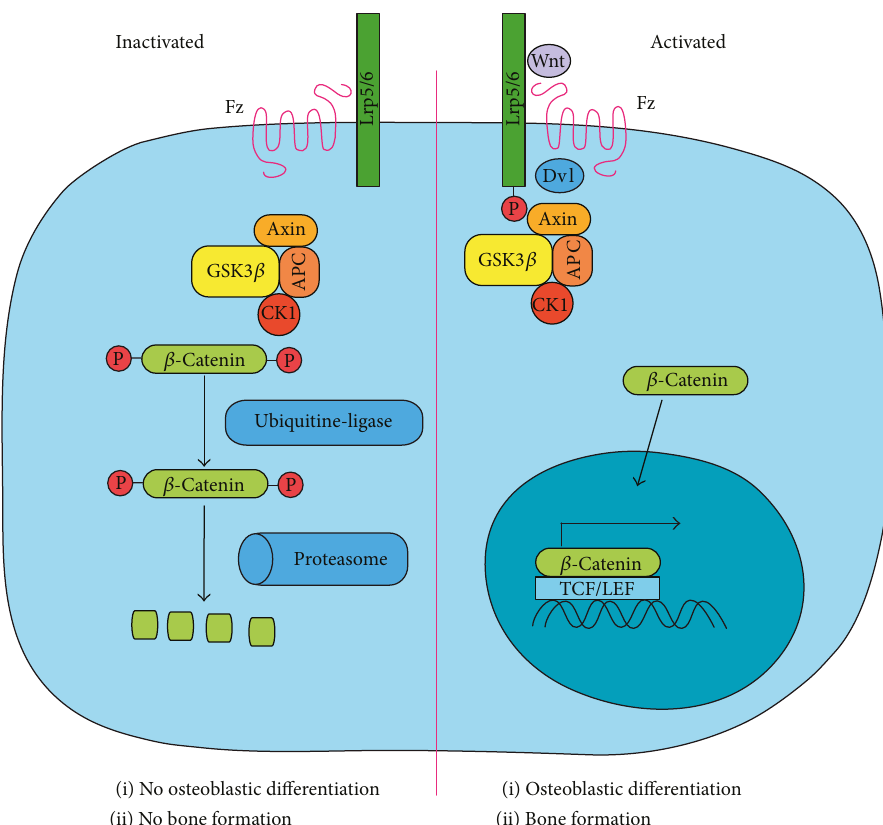
Figure 2: Wnt/ β -catenin pathway and bone formation. On the left, no Wnt ligand is present and the phosphorylation complex, which consists of GSK3 β , APC, CK1, and Axin, can freely phosphorylate β -catenin. This phosphorylation signals to an ubiquitin ligase that β -catenin has to be marked by degradation by the proteasome. On the right, a Wnt ligand binds to Frizzled (Fz) receptor and Lrp5/6 coreceptor. This causes Dvl to phosphorylate Lrp5/6, leading to the recruitment and subsequent inactivation of the phosphorylation complex. β -Catenin is free to translocate to the nucleus and act as a transcription factor for osteoblastic